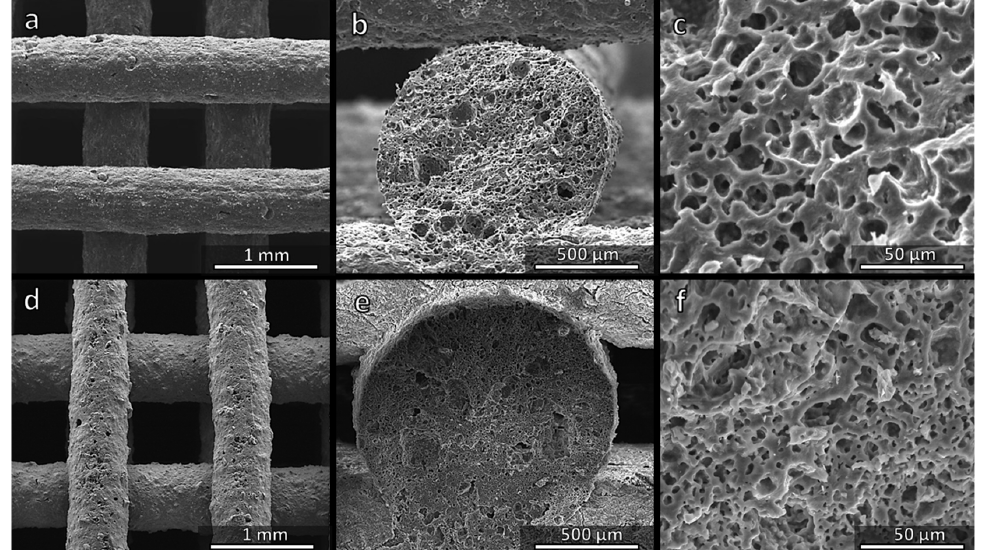
Figure 4. Comparison of the microstructure of Biosilicate ® -like scaffolds fired in air, from MK ( a – c ) and H44 ( d – f ) silicone polymers.